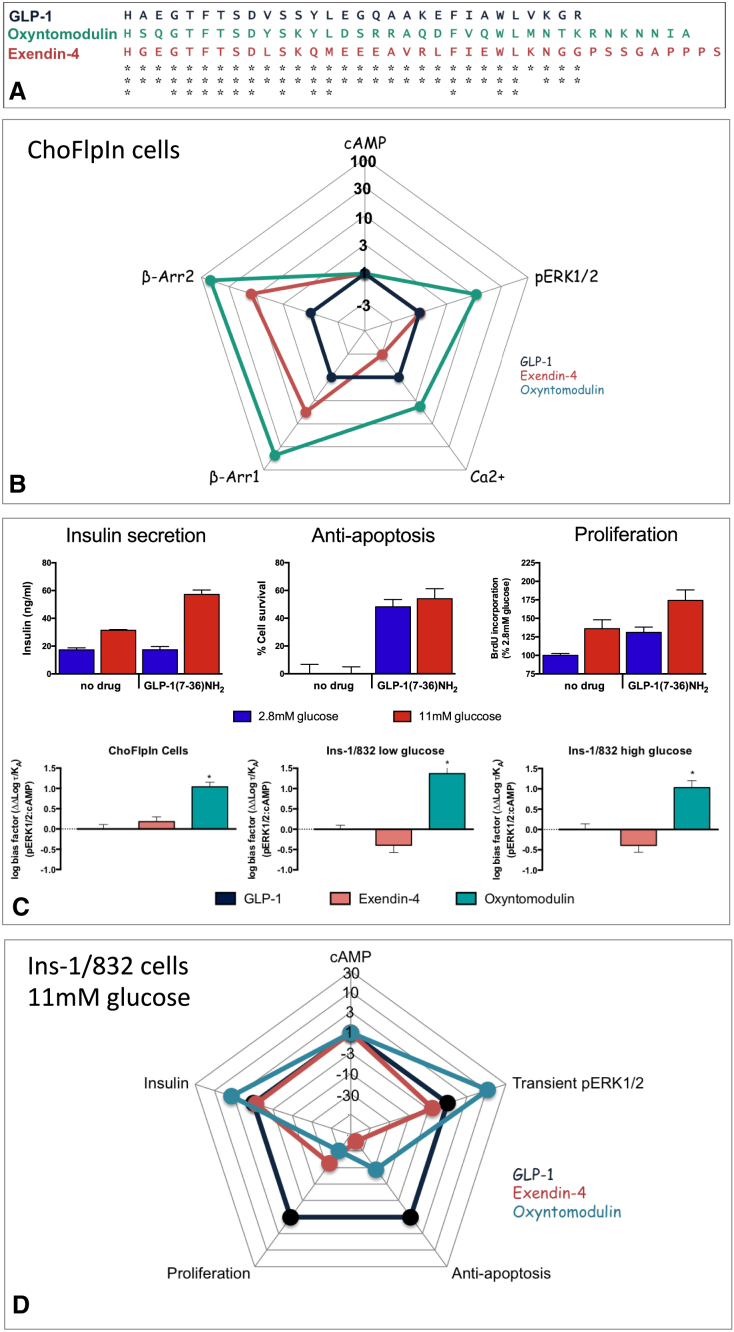
Assessment of Biased Agonism Reveals Distinctions in the Pattern of Signaling by GLP-1, Oxyntomodulin, and Exendin-4 at the GLP-1R in Both Recombinant and Natively Expressing Cells, Related to Figures 3, 4, 5, and 6(A) Alignment showing the degree of sequence conservation between GLP-1, oxyntomodulin, and exendin-4.(B and D) The “web of bias” plots ΔΔτ/KA values on a logarithmic scale for each ligand, for different signaling pathways in ChoFlpIn recombinant cells and Ins-1/832/3 insulinoma cells. Formation of these values included normalization to the reference ligand GLP-1 and the reference pathway, cAMP accumulation. Note, the plots do not provide information on absolute potency, but on relative efficacy for signaling of individual pathways to that for cAMP.(C) Top panel: Assessment of insulin secretion, apoptosis and proliferation confirms that the Ins-1/832/3 cells are a suitable model for GLP-1R signaling beta islets with GLP-1 promoting glucose-dependent insulin secretion, in addition to promoting proliferation and decreasing apoptosis; these cells were used to reveal bias between GLP-1 and both exendin-4 and oxyntomodulin in insulin secretion, proliferation, and apoptosis (D). Bottom panel: comparison of biased agonism for cAMP promotion and pERK1/2 in ChoFLpIn cells (left), Ins-1/832/3 insulinoma cells in low glucose conditions (2.8 mM) (middle) and Ins-1/832/3 insulinoma cells in high glucose conditions (11 mM) (right). These data revel the biased profile of oxyntomodulin observed in ChoFlpIn cells overexpressing the GLP-1R translates to the natively expressing insulinoma cell line.